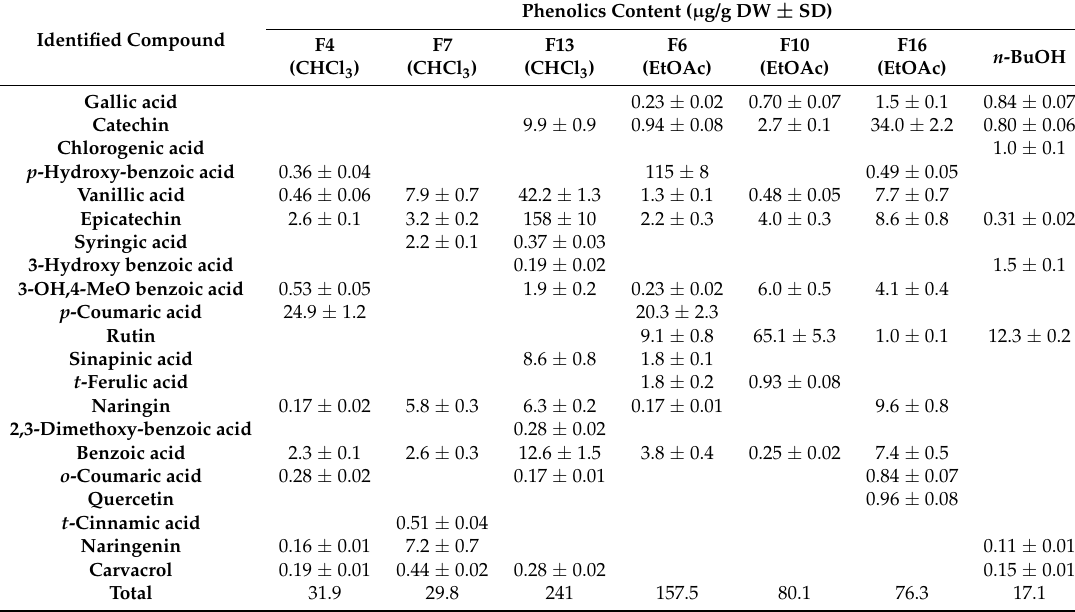
Table 1. Qualitative and quantitative phenolics profile of the main subfractions of Atriplex mollis aerial parts extract by maceration. In the table, the mean values and standard deviations of three independent measures are